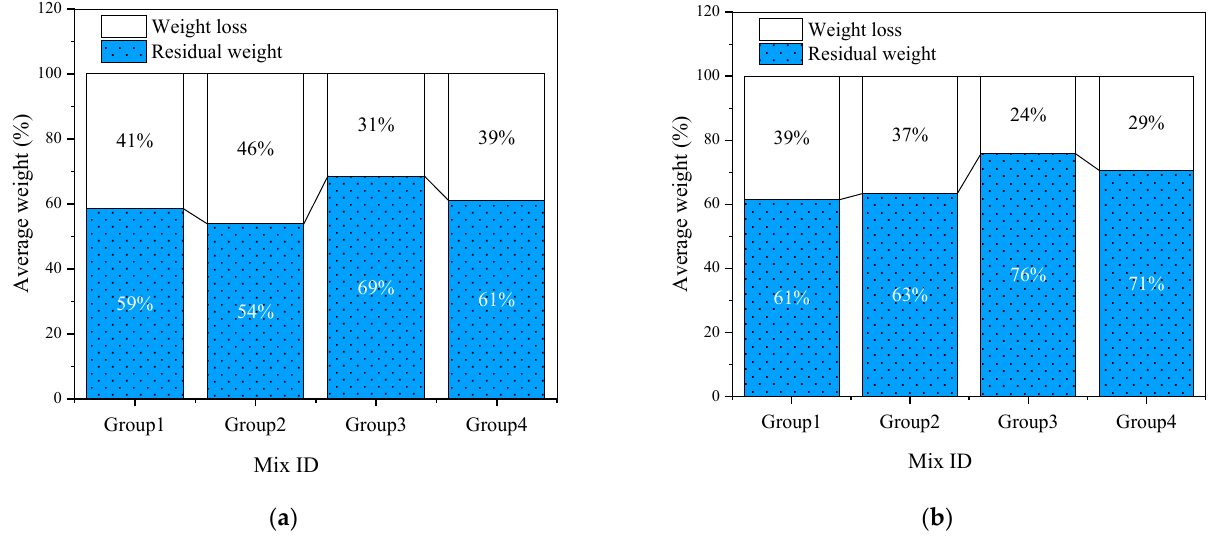
Figure 5. The average abrasion resistance level of each group of samples: ( a ) Average abrasion resistance level of each group of samples; ( b ) Average abrasion resistance level of each group of samples after removing the lowest water/binder ratio.